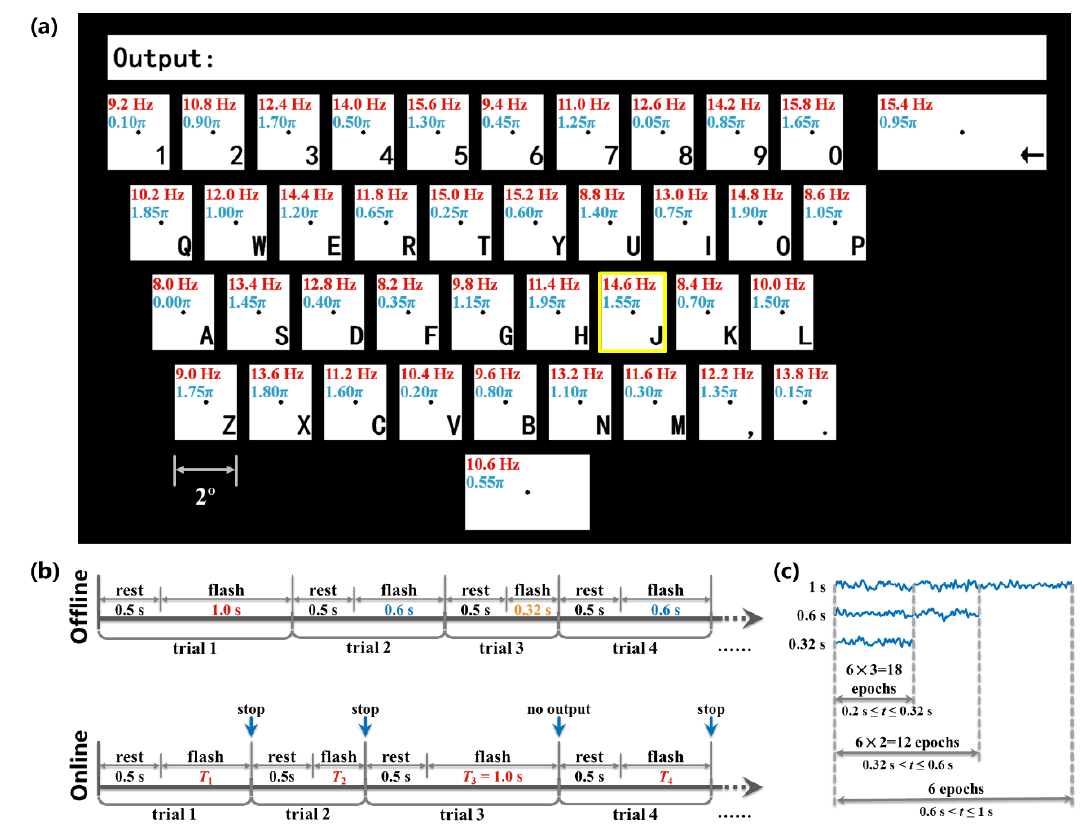
Figure 2. The stimulus design of the 40-target steady-state visual evoked potential (SSVEP)-based brain–computer interface (BCI) system. ( a ) Schematic of the stimulation, in which the 40 targets were distributed according to the layout of a keyboard and the frequency and phase of each target were marked out at upper left corner. The cue was presented to subjects as a yellow rectangle around the target. ( b ) Trial timing diagram of the experiment. ( c ) Three kinds of EEG epochs corresponding to different data lengths were obtained after offline experiment.